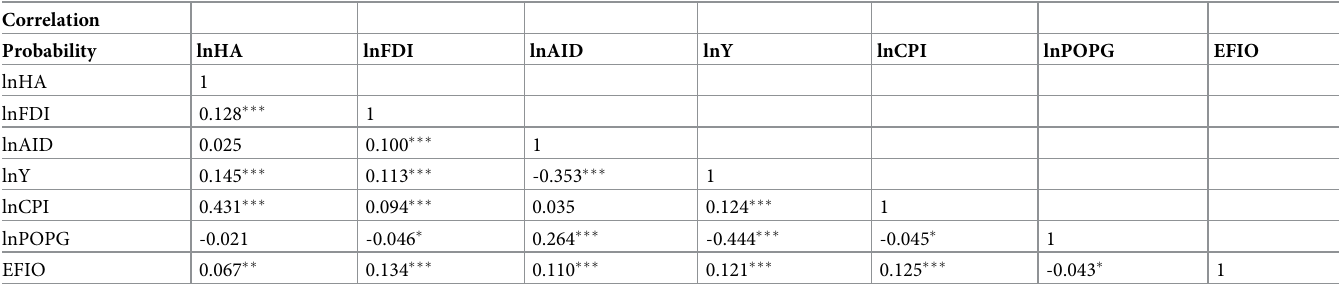
Table 5. Correlation matrix (Source: Authors’ construct).